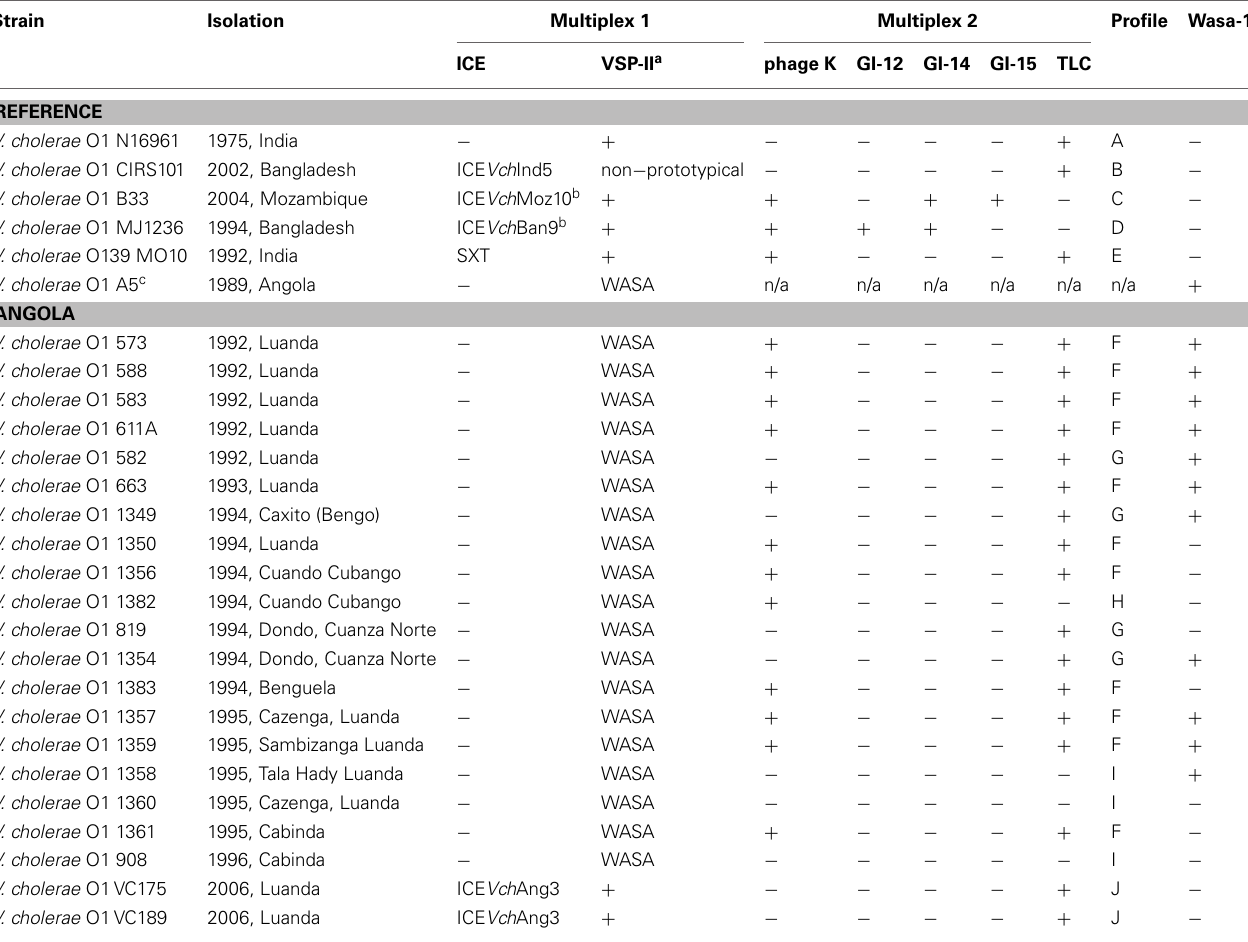
Table 1 | V. cholerae strains analyzed in this